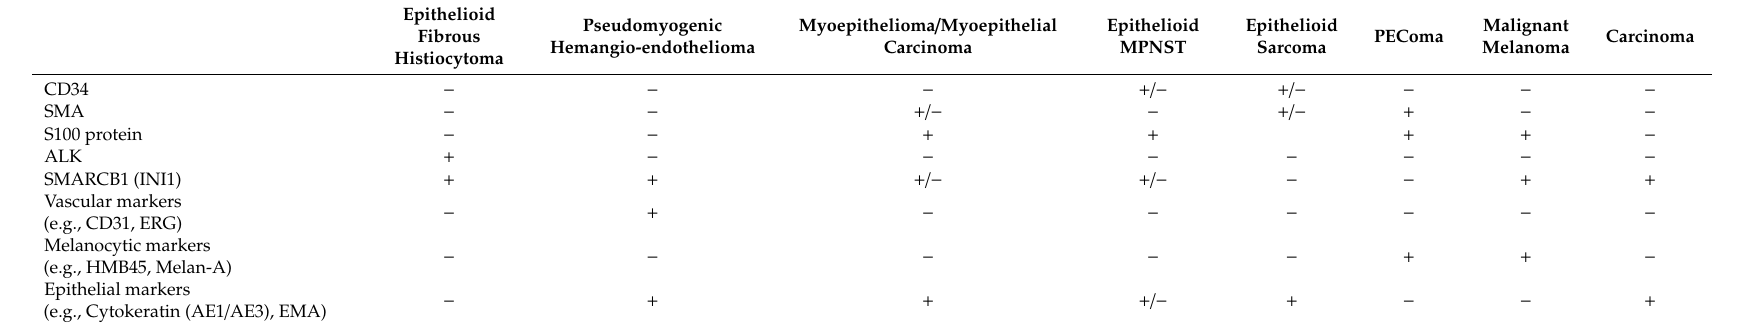
Table 2. Immunoreactivity of selected epithelioid cutaneous